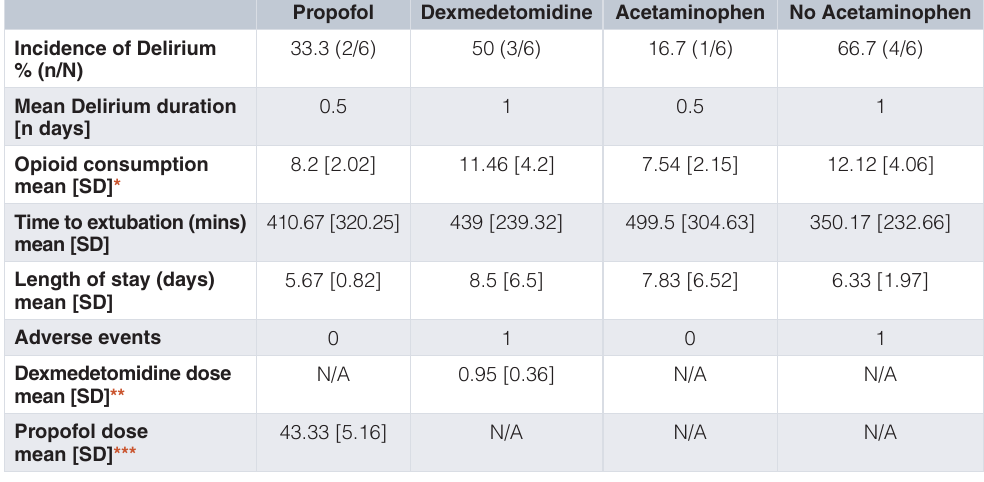
Table 2. Table 2 provides the incidence of delirium and secondary outcomes in the groups receiving propofol, dexmedetomidine, acetaminophen, and no acetaminophen respectively. Propofol